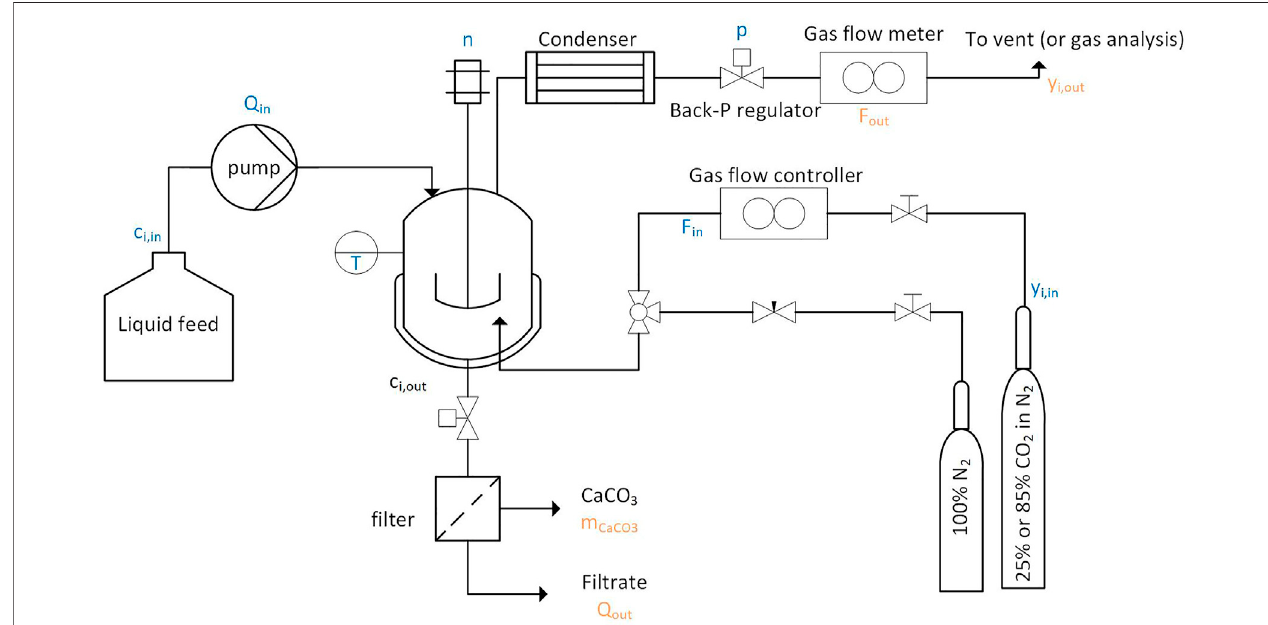
FIGURE 1 | A schematic drawing of the crystallizer modeled in the scope of this project is shown. The experimental setup is described to a greater detail in a previous publication (Tiefenthaler and Mazzotti, 2021).